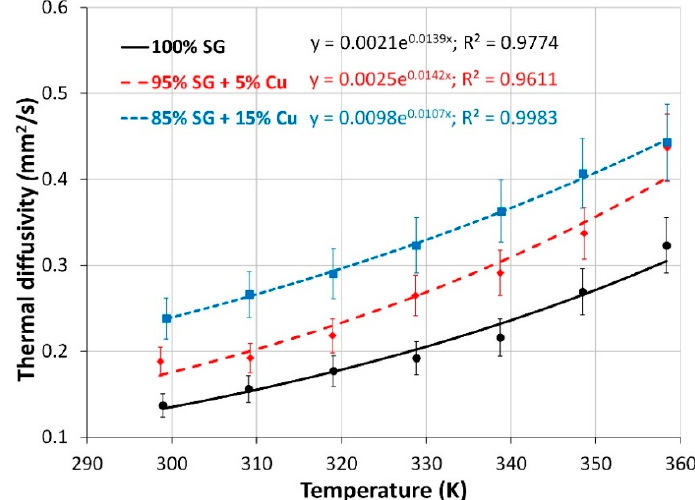
Figure 4. Effect of Cu additives on the thermal diffusivity of the SG-based adsorption bed. Figure 4. E ff ect of Cu additives on the thermal di ff usivity of the SG-based adsorption